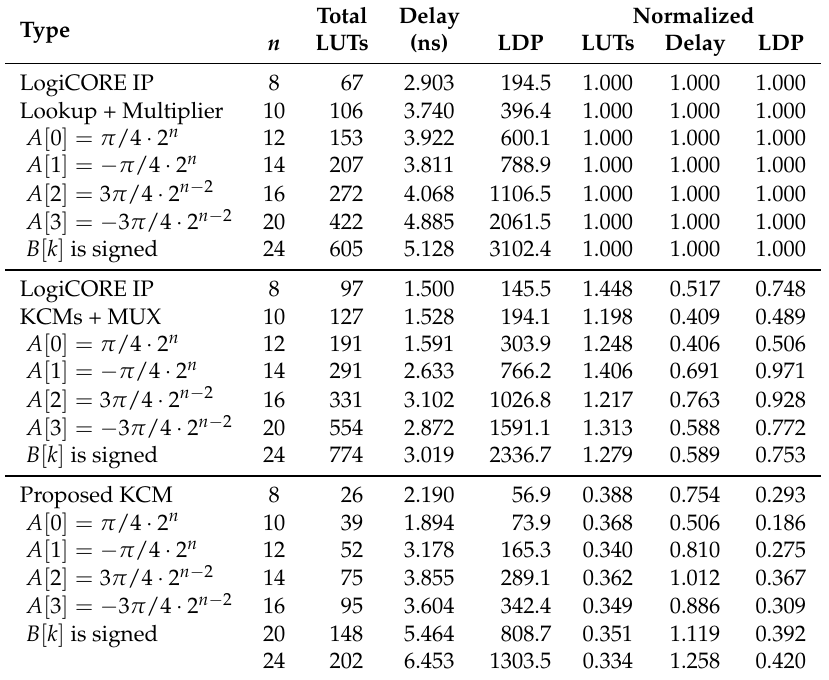
Table 9. Synthesis results for single-cycle ( m × n )-bit KCMs with four selectable coefficients where 64% fewer LUTs on average compared to LogiCORE IP multiplier-based units and 73% fewer LUTs on average compared to LogiCORE IP KCM-based